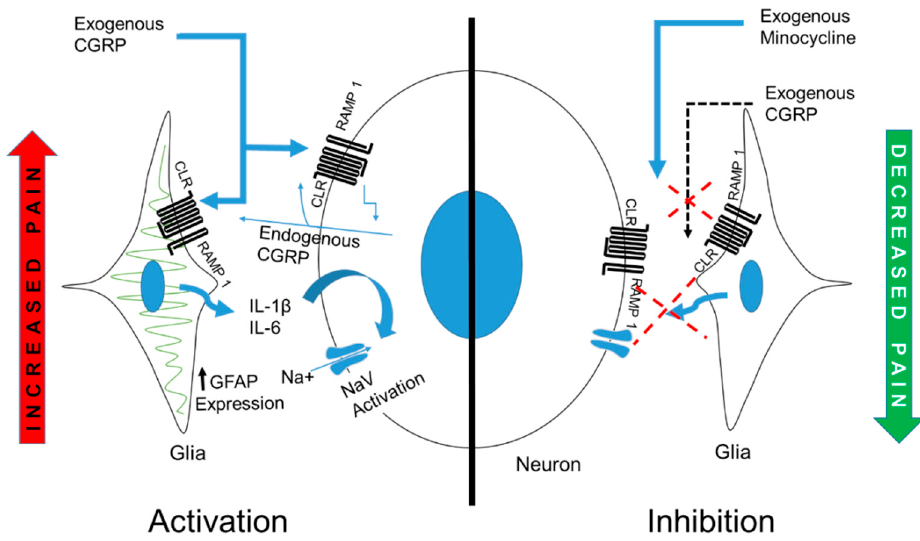
Figure 9. Schematic representation of the effect of exogenously administered CGRP on neurons and SGCs. CGRP receptors are present on the SGCs and neurons [namely, receptor activity-modifying protein 1 (RAMP1), and calcitonin receptor-like receptor (CLR)]. Injected CGRP causes its activity by engaging these receptors and causing activation of SGCs as demonstrated by an increased expression of GFAP. Pro-inflammatory cytokines IL-1 β and IL-6 are released from the SGCs in the TG and these cytokines cause neuronal activation as shown by upregulation of NaV 1.7. Hypothetically, once initiated these effects are self-sustaining because of the formation of a feedback loop due to the secretion of endogenous CGRP and responsible for hyperalgesia as observed at 6 h in the present experiment. Injecting Min (a glial inhibitor) reduced the effect of CGRP, leading to an alleviation of hyperalgesia.